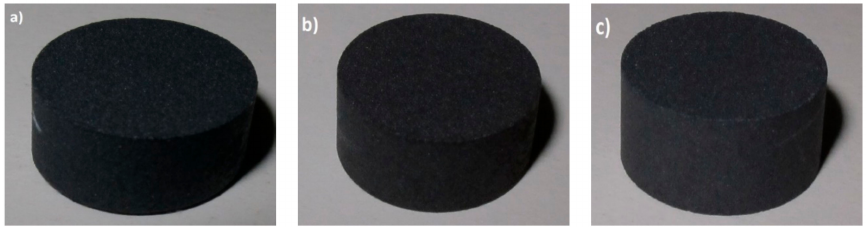
Figure 2. Photographs of the anodized Ti-15Mo discs treated in the electrolytes of series 9 ( a ), 10 ( b ), and 11 ( c ).